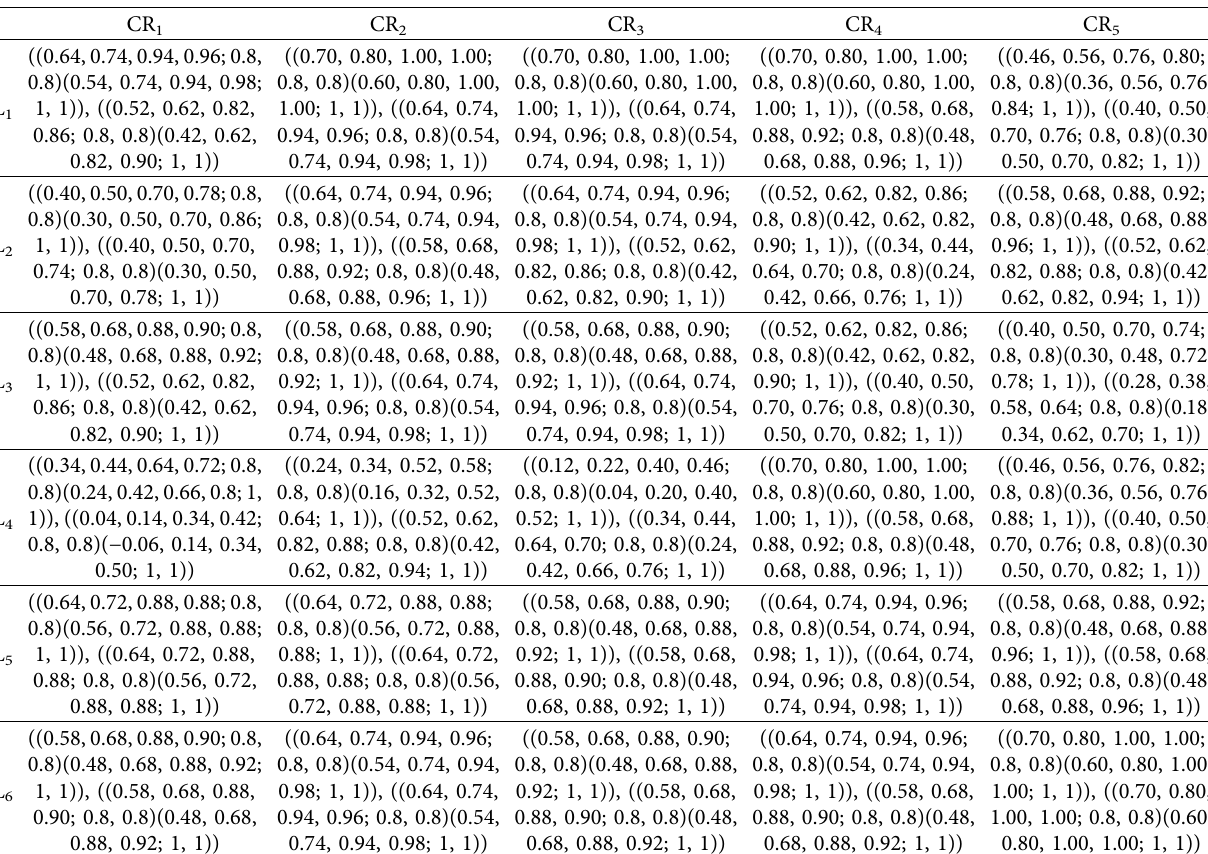
Table 4: Te judgment